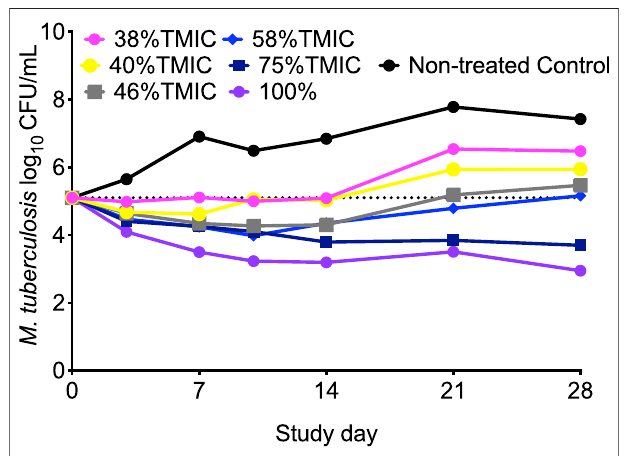
FIGURE 3 | Cefazolin kill curves of intracellular Mtb in the HFS-TB. We pooled the cefazolin twice-daily exposures that were similar to once daily for clarity in the fi gure. Exposures ≥ 75% T MIC kept the bacteria below stasis and the extent of kill was 2.52 log 10 CFU/mL below stasis on day 28 of the study.